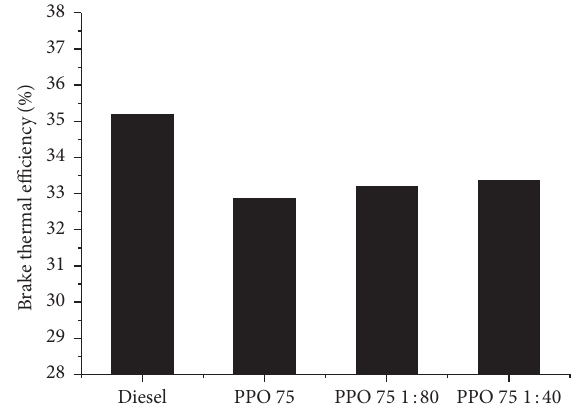
Figure 10: Variation of BTE at 85% load.